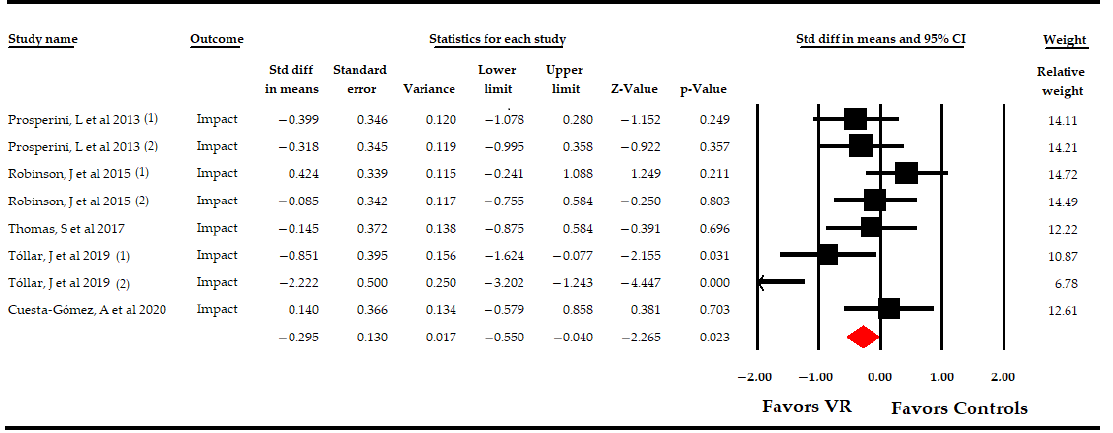
CT, and VR + CT vs. CT (Table 4, Figure 5). Firstly, three studies [56,58] compared the